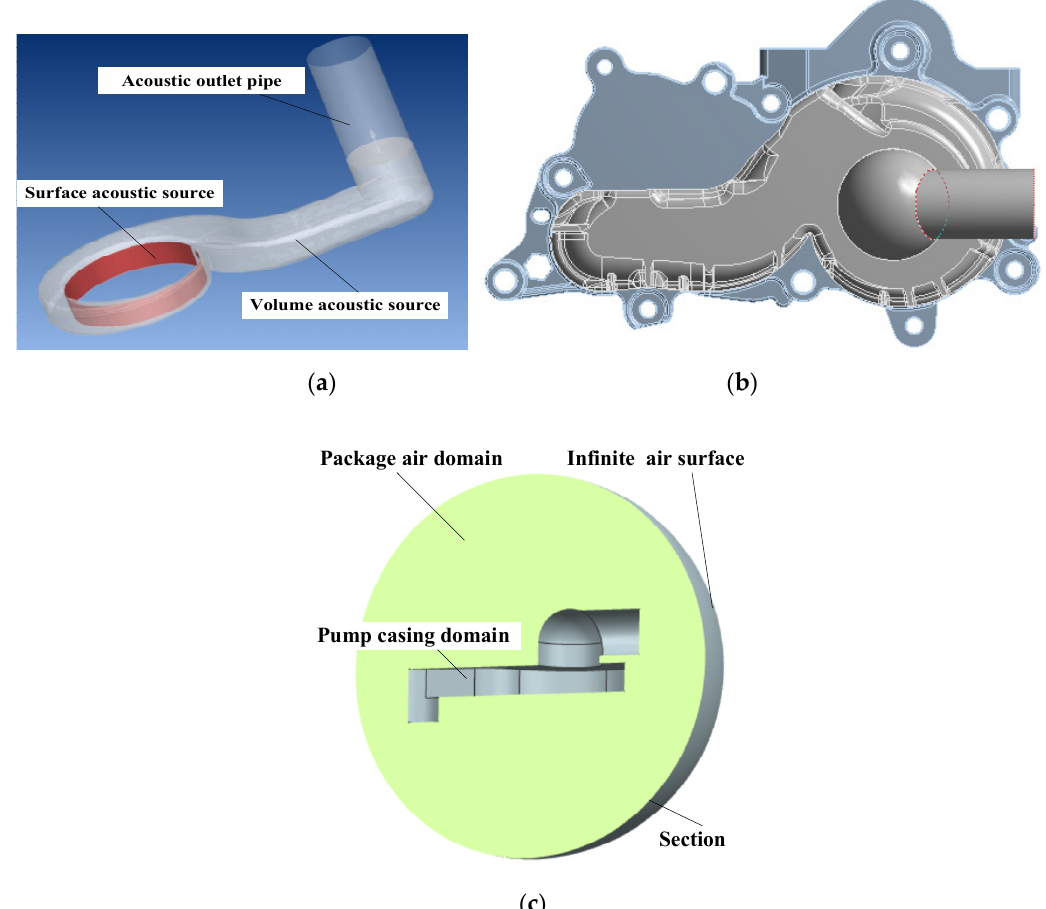
Figure 6. The sound field calculation: ( a ) water flow domain; ( b ) pump casing structure; ( c ) air radiation sound fields.